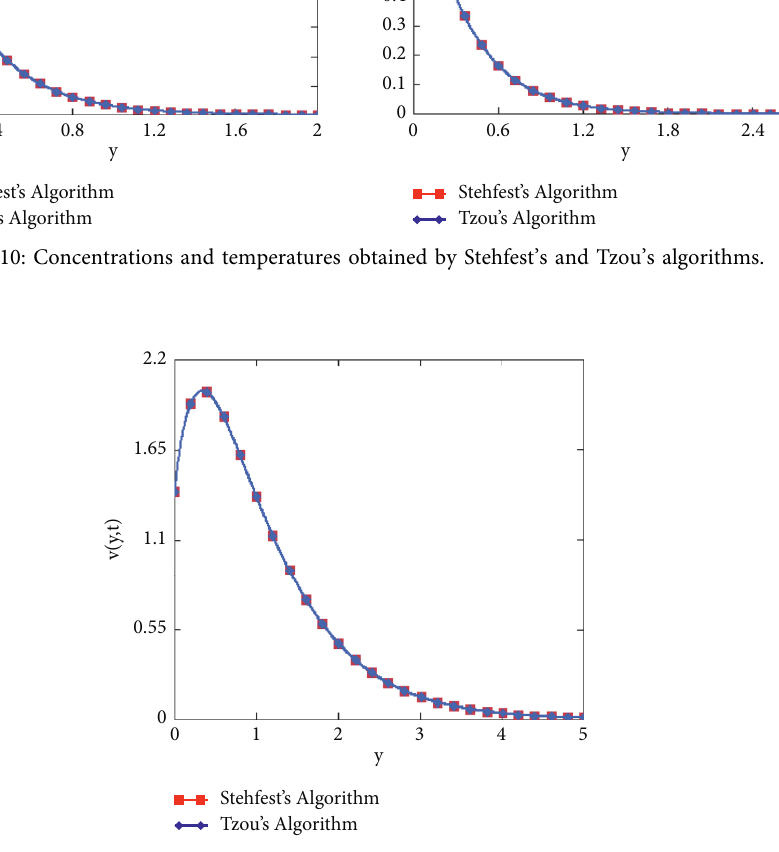
Figure 11: Velocity profile obtained by Stehfest’s and Tzou’s